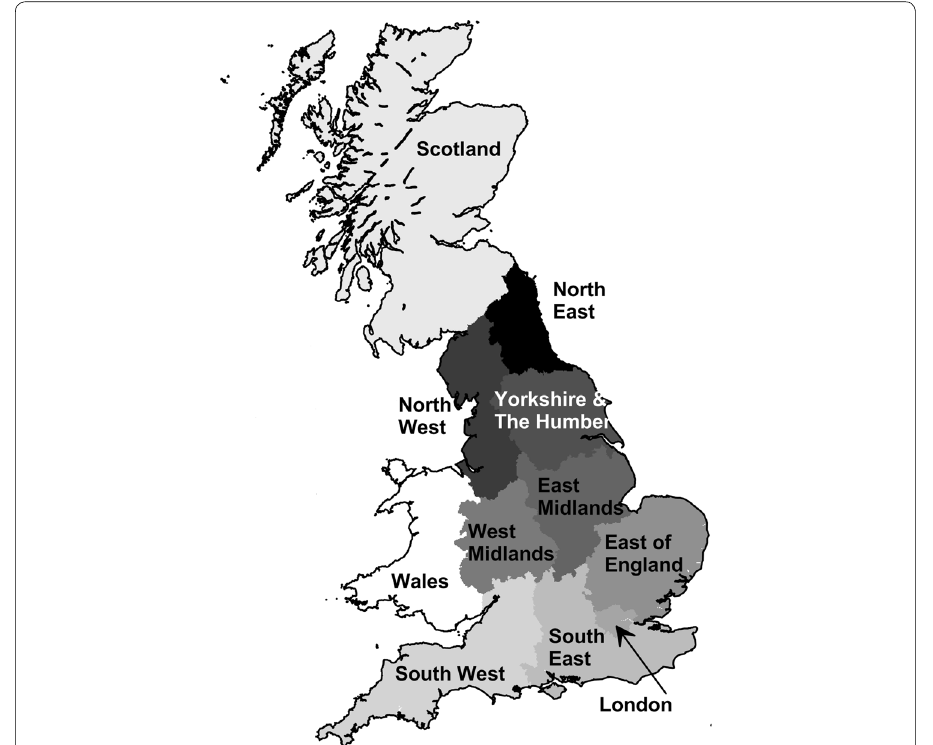
Fig. 6 Regions of Great Britain (Office for National Statistics Open Geography Portal:https://data.gov.uk/ dataset/regionsdecember-2014-generalised-clipped-boundaries-in-great-britain1/resource/ab19204b-4b88-